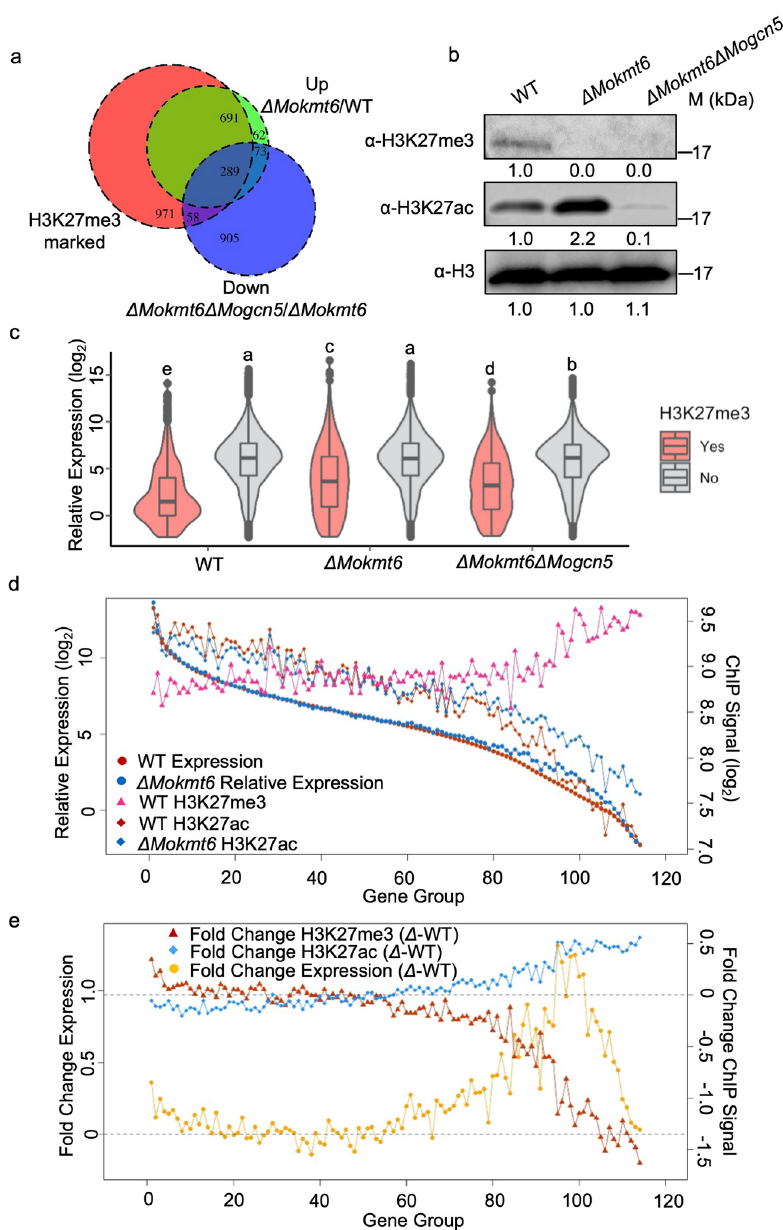
Fig 4. Loss of trimethylation and gain of acetylation at H3K27 contribute to H3K27me3-marked gene expression. (A) Venn diagram illustrating a subset of genes marked by H3K27me3 are up regulated in the mutant Δ Mokmt6 compared with Guy11 wild type (WT) and some of them are downregulated by further loss of H3K27ac in the double mutant Δ Mokmt6 Δ Mogcn5 . All genotypes are grown in liquid complete medium (CM). (B) Western blotting analysis of protein extracted from wild type (WT), the deletion mutant Δ Mokmt6 with absence of H3K27me3, and the double deletion mutant Δ Mokmt6 Δ Mogcn5 with absence of H3K27me3 and reduced of H3K27ac. Blots were probed with the indicated antibodies. (C) Violin plots showing H3K27me3-marked genes are significantly upregulated in mutants Δ Mokmt6 and Δ Mokmt6 Δ Mogcn5 . (D) Genome-wide visualization of relationships between ChIP signals for H3K27me3/H3K27ac and gene expression across wild type and mutant Δ Mokmt6 abolishing H3K27me3. Total of 11,327 expressed genes out of 12, 101 gene models were divided into 114 groups (100 genes in one group) according to their expression levels from high to low (x axis). The dots, triangles, and diamonds represent the average levels of gene expression, ChIP signal for H3K27me3, and H3K27ac in each group, respectively. (E) Genome-wide visualization of relationships between fold change of ChIP signals for H3K27me3/H3K27ac and fold change of gene expression. The fold changes of ChIP signals or gene expression were calculated by subtracting the average levels of ChIP signals or gene expression of individual gene group in wild type (WT) from the mutant Δ Mokmt6 ( Δ ).